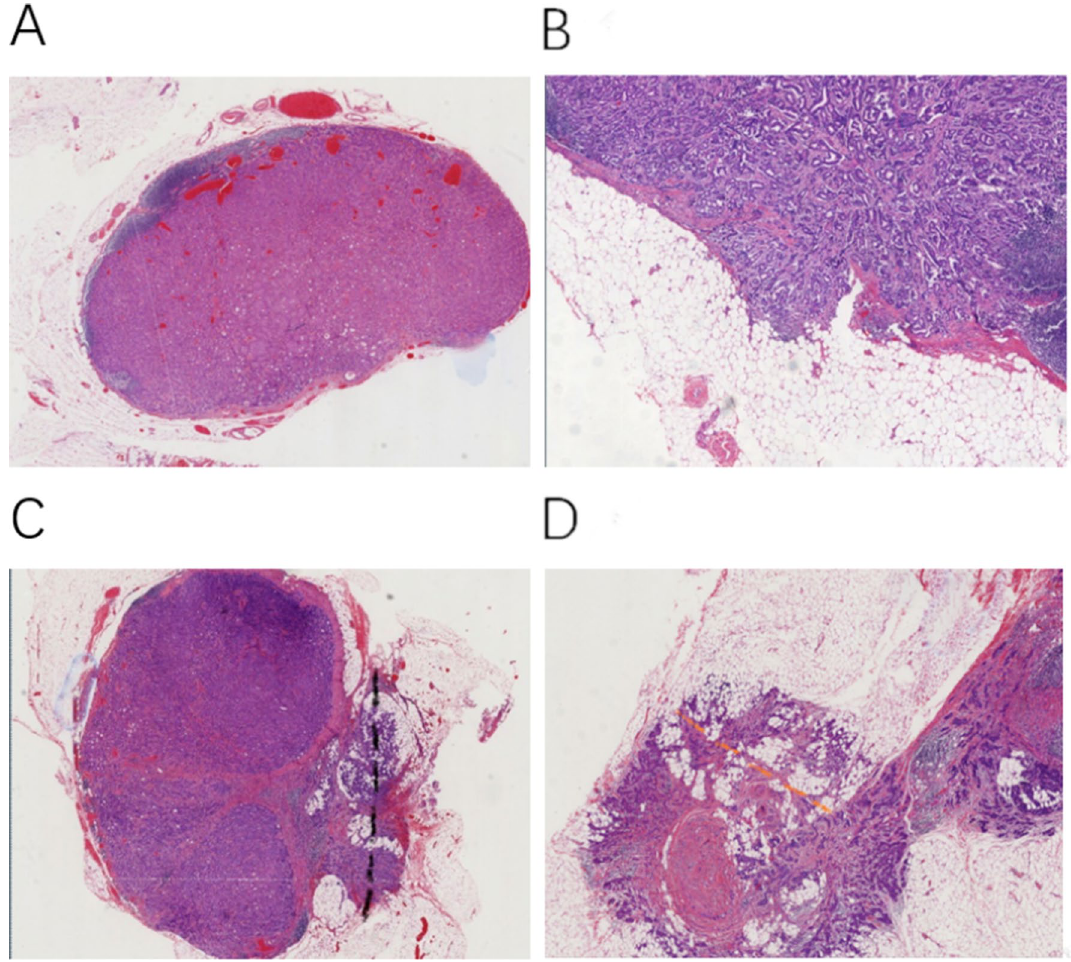
Figure 1. ( A ) Involved axillary lymph node (ALN) without extranodal extension (ENE), ( B ) ALN with ENE, ( C ) the diameter of CD-ENE, ( D ) the diameter of PD-ENE. Original magnification: